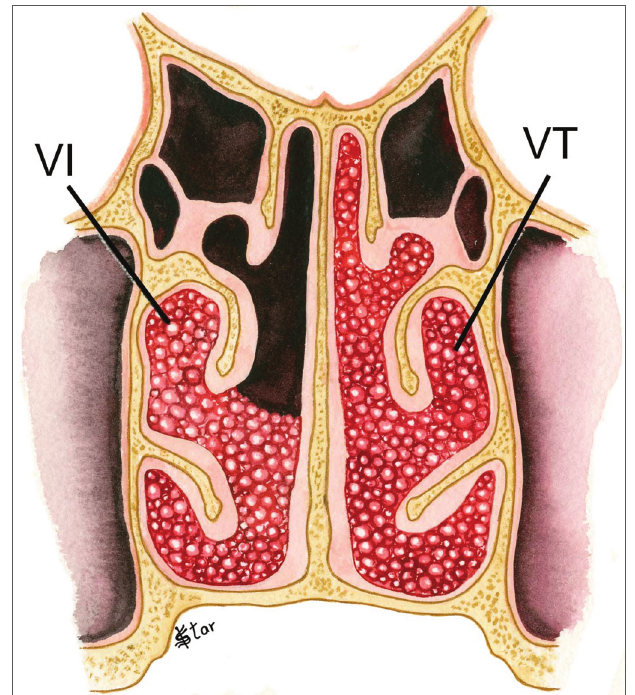
Figura 4. Estadiamento da PN no plano Vertical - VI - pólipos com extensão inferior ao meato médio VT - pólipos ocupando toda extensão vertical da fossa nasal